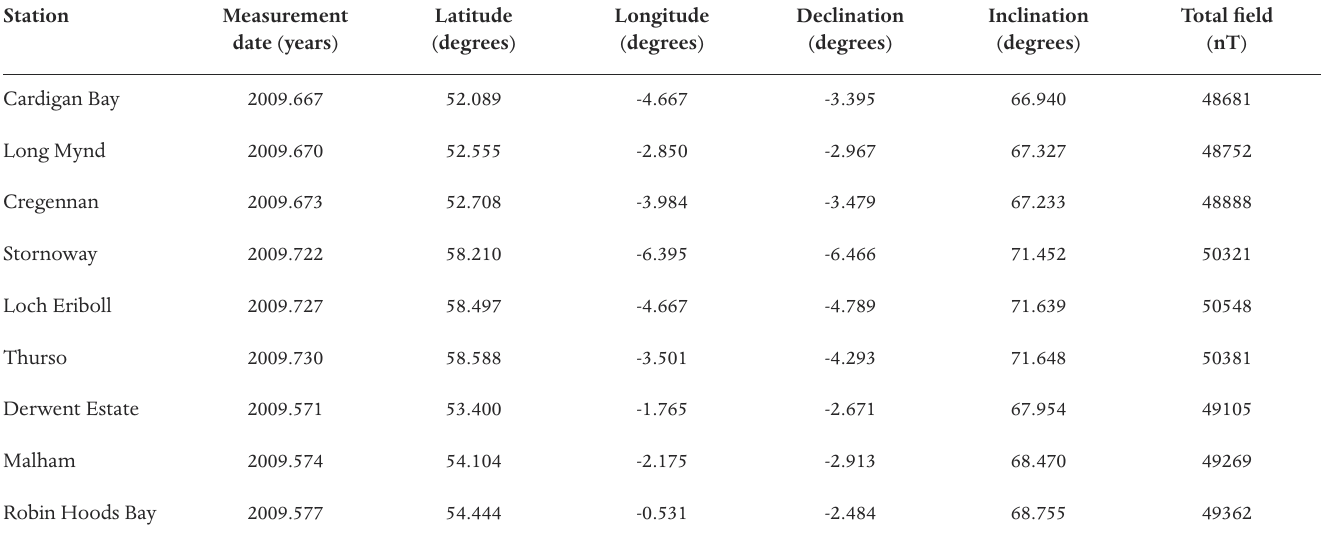
Table 1. 2009 repeat station results (reduced to quiet time).